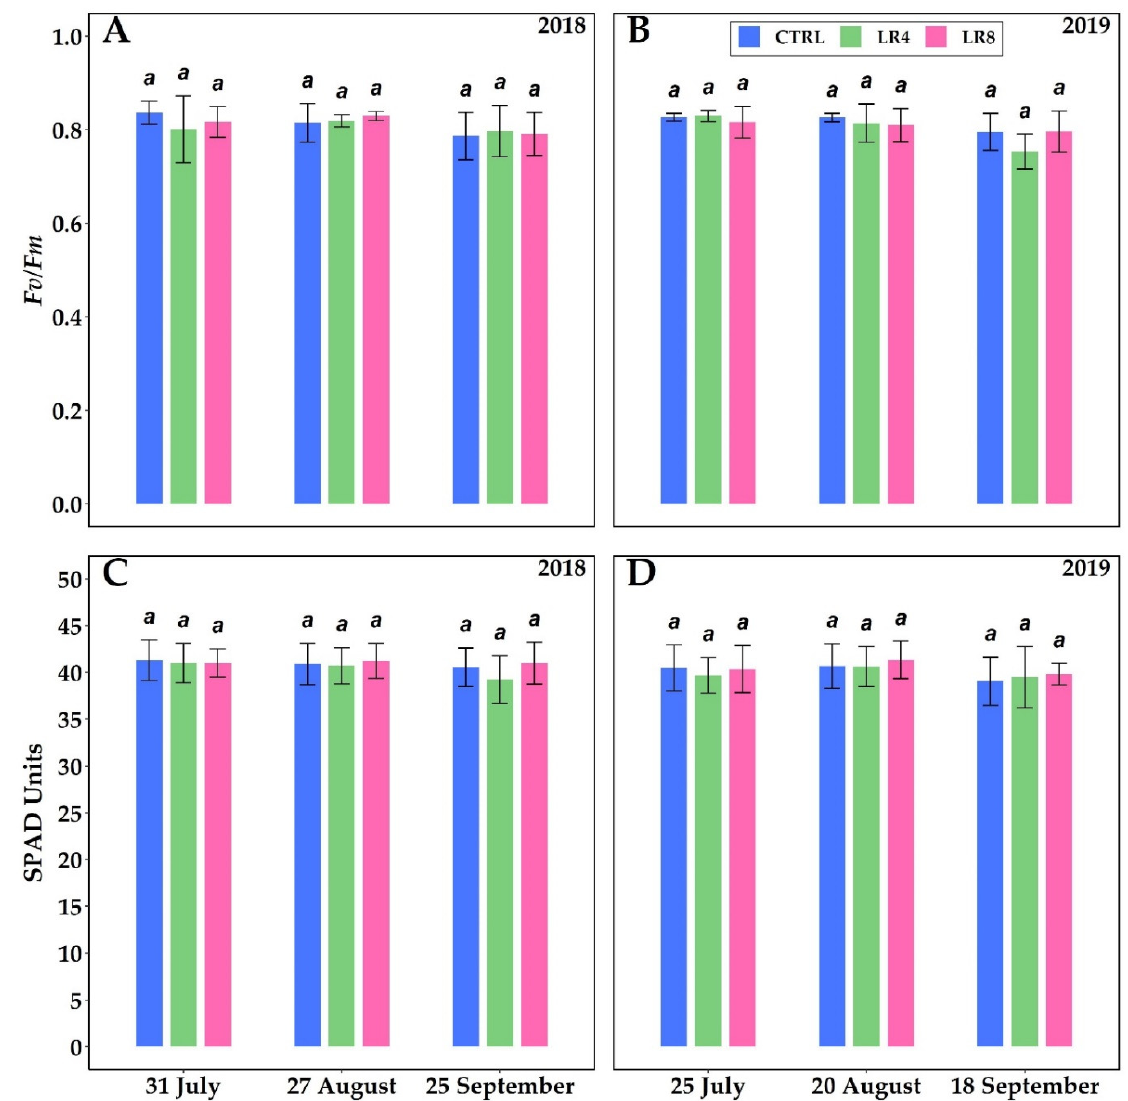
Figure 2. Maximum quantum yield of PSII (F v /F m ) (( A ), 2018; ( B ), 2019) and chlorophyll content (SPAD Units) (( C ), 2018; ( D ), 2019) in V. vinifera with three different defoliation management methods: four leaf removal (LR4, green column), eight leaf removal (LR8, pink column), and no defoliation (CTRL, blue column). Measurements were conducted at full veraison (31 July 2018 and 25 July 2019), mid-maturation (27 August 2018 and 20 August 2019) and full maturation (25 September 2018 and 18 September 2019). Different letters within the same parameter indicate significant differences. Data (mean ± SE, n = 10) were subjected to one-way ANOVA (LSD test, p ≤ 0.05).